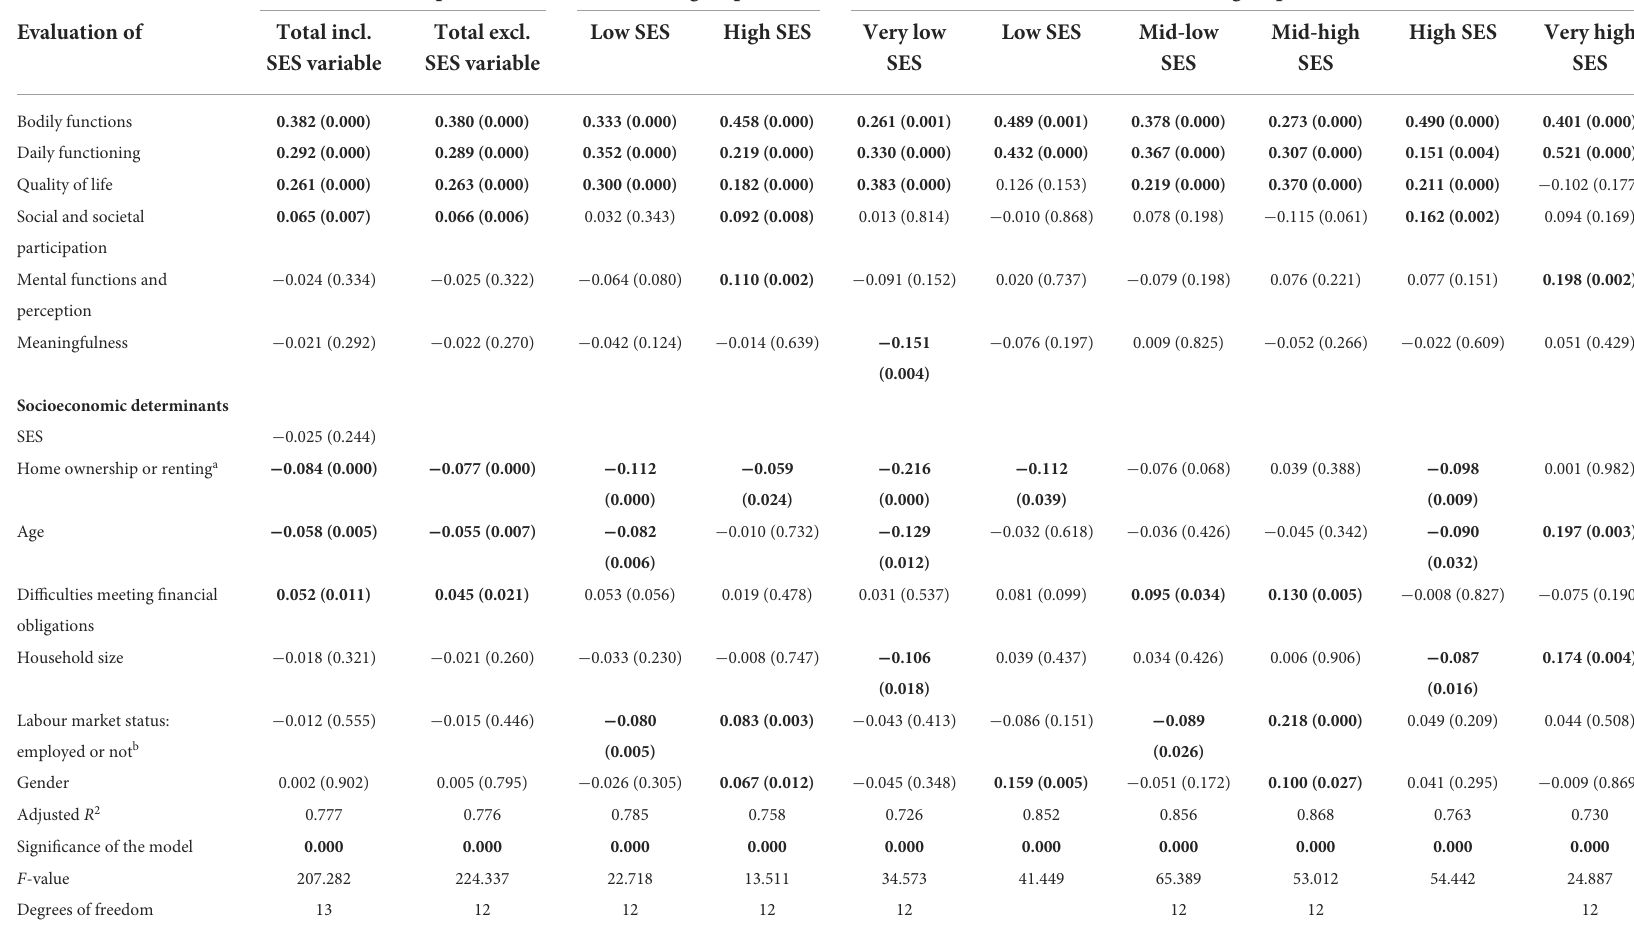
TABLE 4 Multiple regression analyses explaining total general